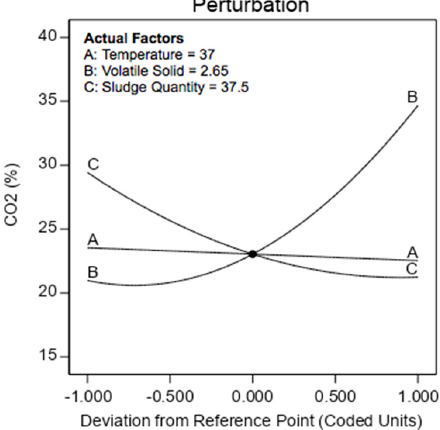
Figure 13. Interaction plot clarifying the effect of interaction between volatile solid and sludge quantity on CO 2 %.